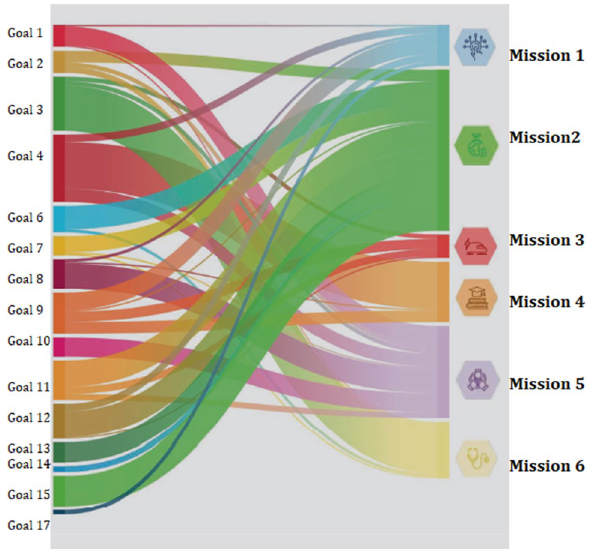
Figure 1. Relationships between SDGs indicators and NRRP